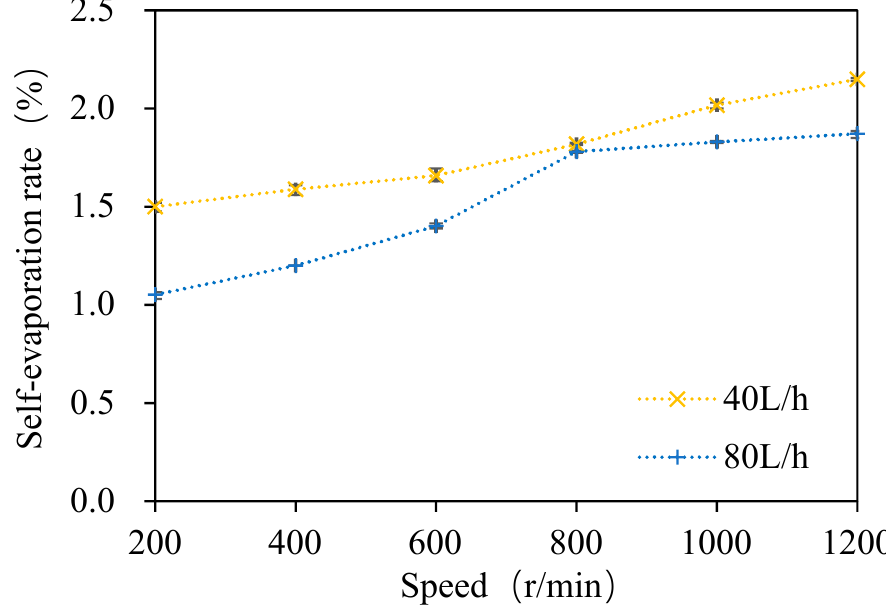
Figure 6. Variation of the self-evaporation rate with the rotating speed. As shown in Figure 7, by comparing the relationship between the removal ratio of DMS to the self-evaporation rate in wort and the rotation speed, no significant linear relationship between the two was observed at a rotation speed of 200–1200 r/min (as shown in Figure 7a). This is because the effect of wort film formation was not ideal when the rotating speed was 200 r/min, and there was more wort effusion at the bottom of the cone (as shown in Figure 4A). However, a significant linear relationship was observed when the rotating speed was 400–1200 r/min (as shown in Figure 7b). It can be concluded that the DMS removal rate has a good correlation with the self-evaporation rate if the effect of wort film formation is ideal. This is consistent with the research conclusion of Feilner et al. regarding the wort turbulent film self-evaporation system [17]. When the wort flow rate was 80 L/h and the rotating speed was 200–600 r/min, there was no significant linear relationship between the DMS removal rate and self-evaporation rate in wort due to the different degrees of effusion at the cone bottom (as shown in Figure